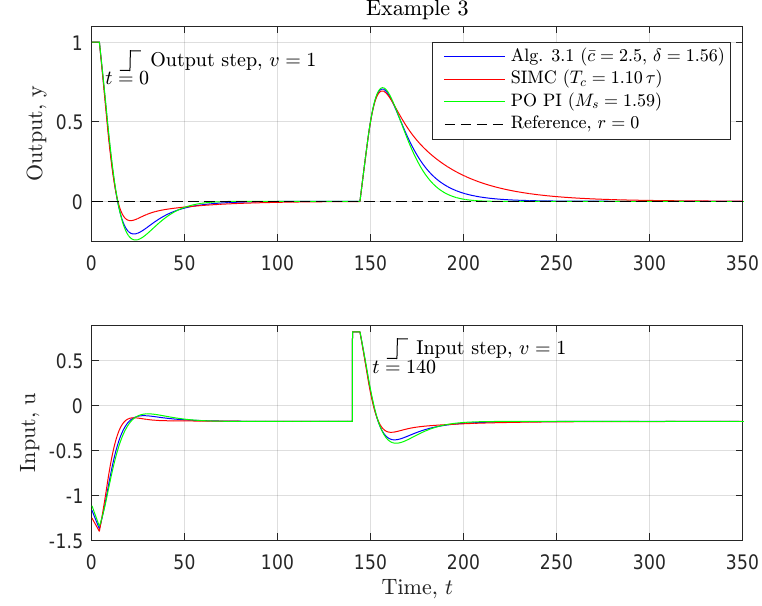
Figure 7. Example 3. Consider PI control of the FOPTD process model, H p ( s ) = K e − τ s τ = 4 and T = 60. The figure illustrates the time-domain responses, given a prescribed robustness M s = 1.59, of the following methods: the PO PI, SIMC with prescribed closed loop time constant T c = 1.10 τ , and Algorithm 1 where the MP parameter ¯ c = 2.5 (proposed in Section 4) and RTDE δ = 1.56. An output disturbance unit step is presented at time t = 0 and an input disturbance unit step at time t =